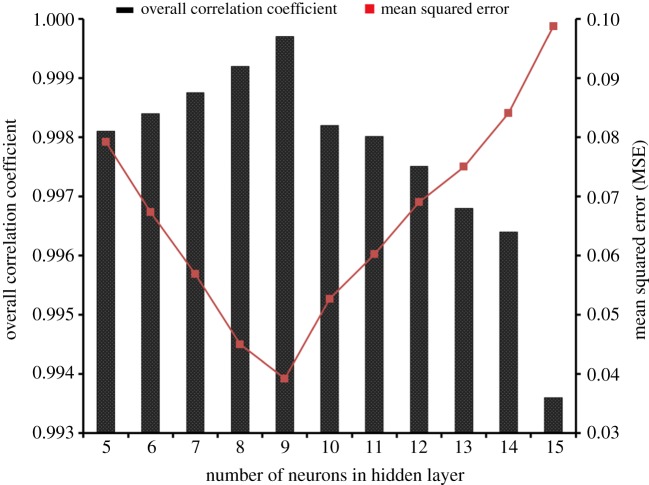
Effect of neuron number on ANN model.